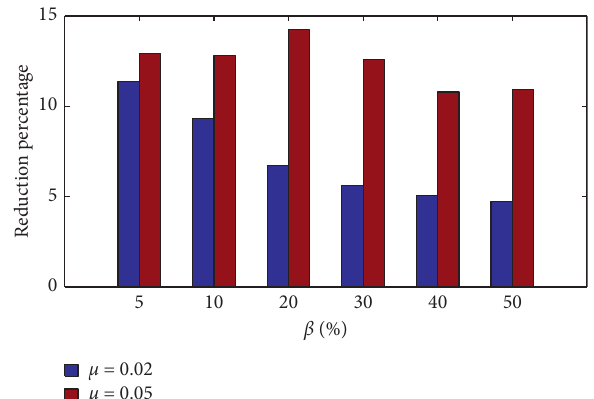
Figure 14: Comparison of the reduction of the 11 th storey RMS value of displacement of the structure subjected to “ Algarrobo ” acceleration record for TMDI designed with µ � 2% and µ � 5% using the J P optimization alternative.